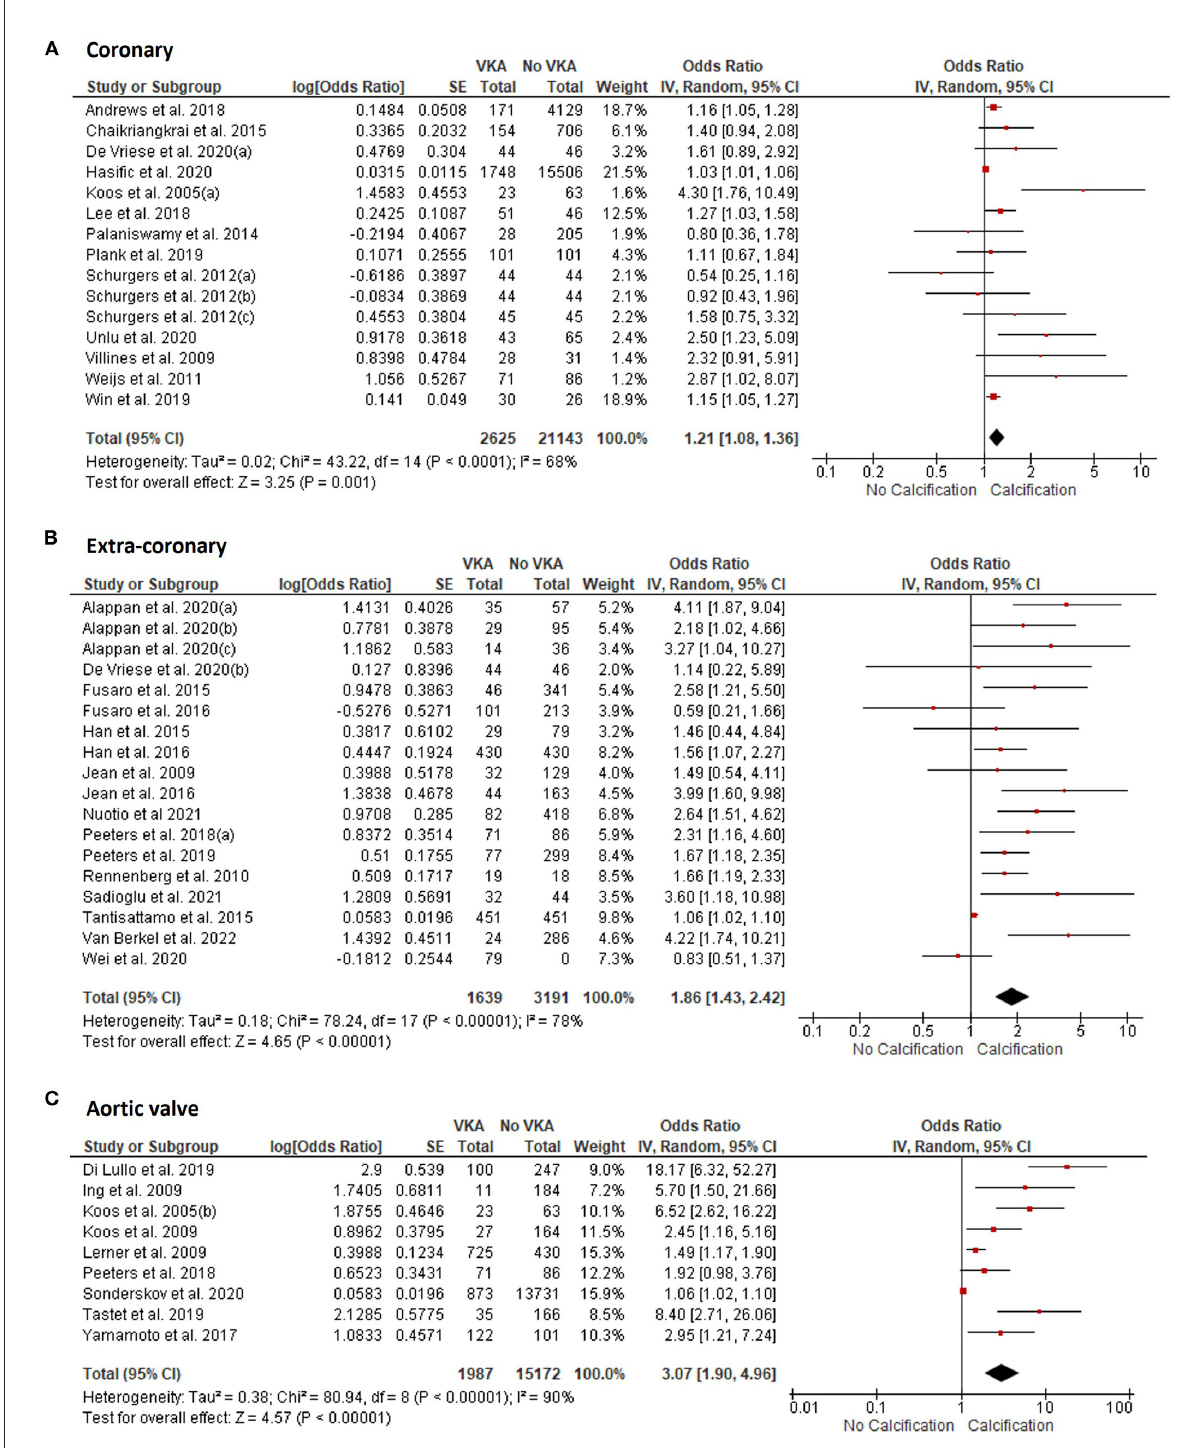
FIGURE2 Meta-analysis of vascular and valvular calcification studies in VKA-treated patients. (A) coronary artery calcification; (B) extra-coronary calcification; (C) aortic valve calcification